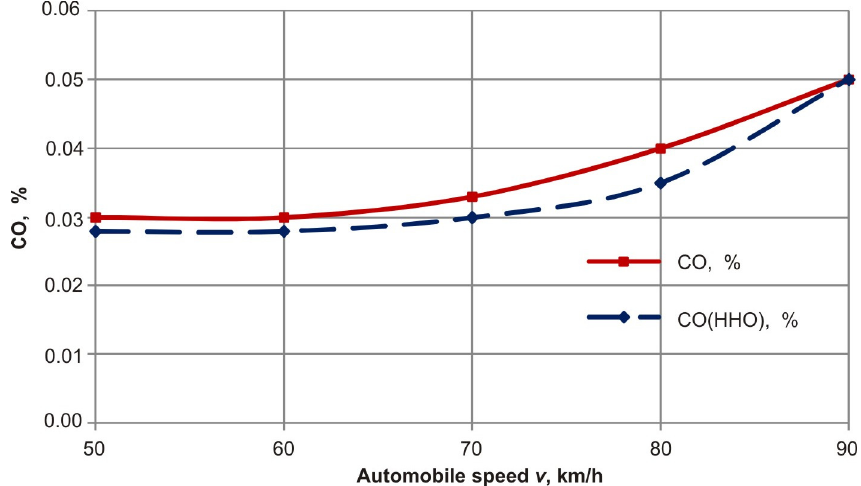
Fig. 2. Amount of CO in exhaust gases